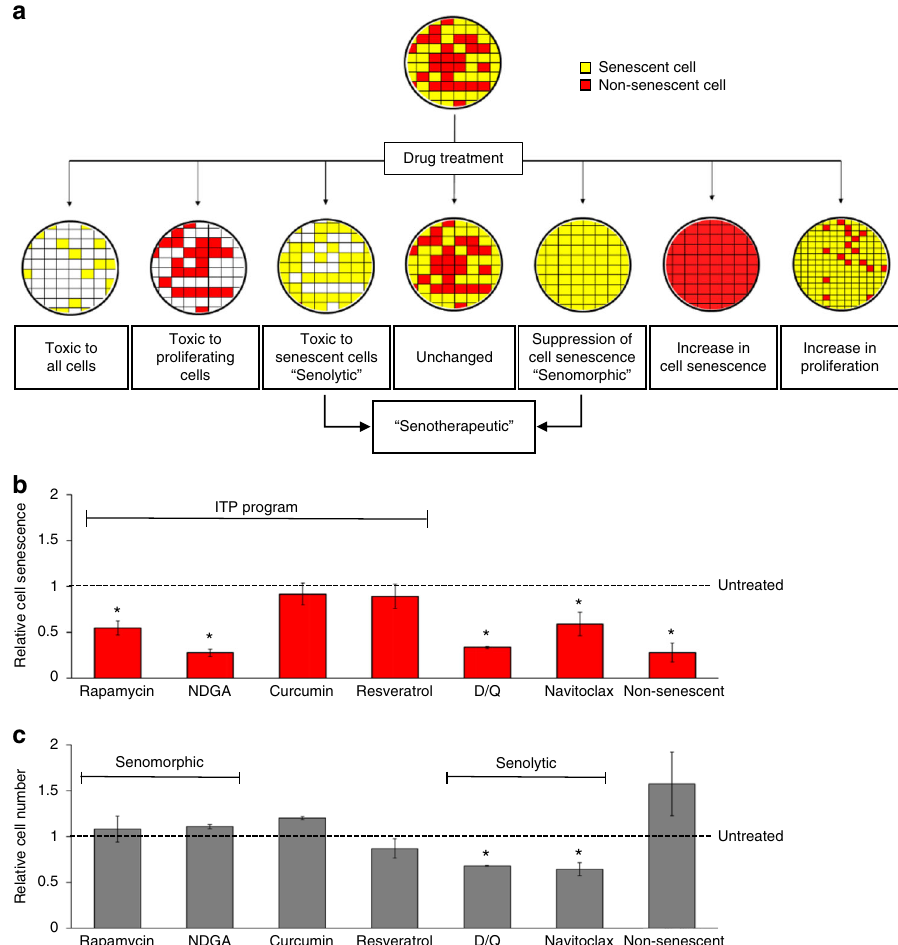
Fig. 3 Characterization of a novel, C 12 FDG single-cell SA-ß-gal drug screening assay. a Scheme of possible outcomes after treating a senescent p5 Ercc1 − / − MEF culture with a potential senotherapeutic. Red = senescent cells, yellow = non-senescent cells. Senotherapeutics are characterized by either killing of senescent cells (senolytics) or by altering the senescent state of cells otherwise (senomorphics). After 48 h treating p5 senescent Ercc1 − / − MEFs with a drug, the relative number of senescent cells b and total cells c remaining is quantitated and plotted relative to untreated control cultures. Red bars indicate relative number of senescent cells, grey bars indicate relative number of total cells. Error bars indicate SD for n = 3. * p < 0.05 for senescent cells, two-tailed Student ’ s t